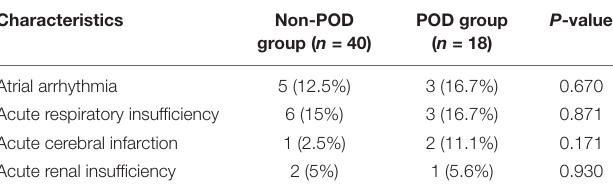
TABLE 3 | Comparison of other post-operative complications among the non-POD and POD